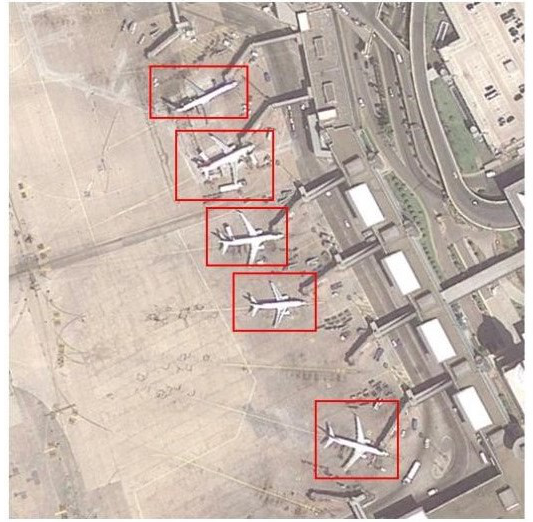
Figure 1. A remote sensing image of the